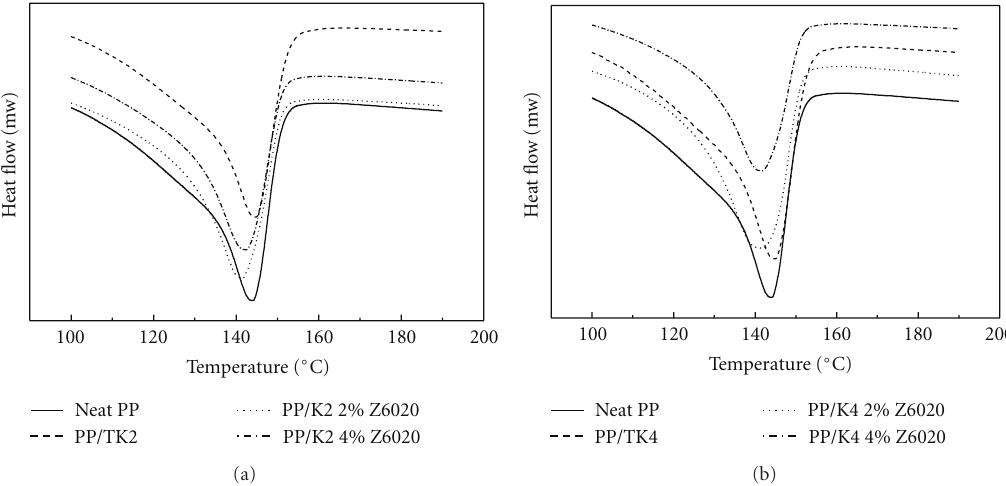
Figure 9: DSC heating thermograms of PP composites containing (a) 2 phr and (b) 4 phr of kaolinite treated with 2% and 4% of silane.